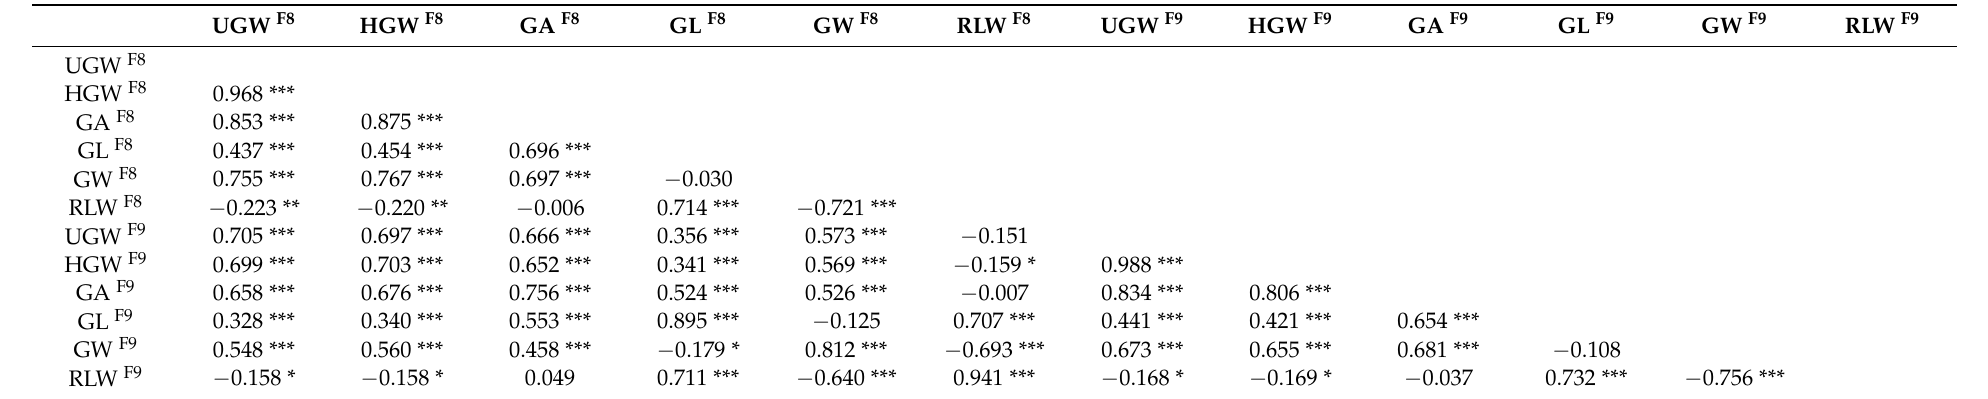
Table 1. Coefficients of correlation among grain size-related traits in the F 8 - and F 9 -generation